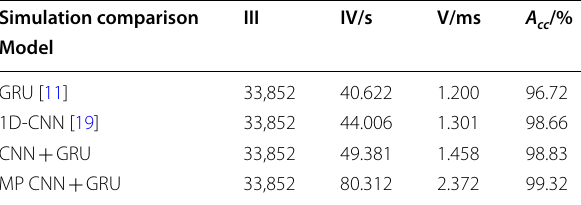
Table 7 Comparison of computation speed on the IEEE